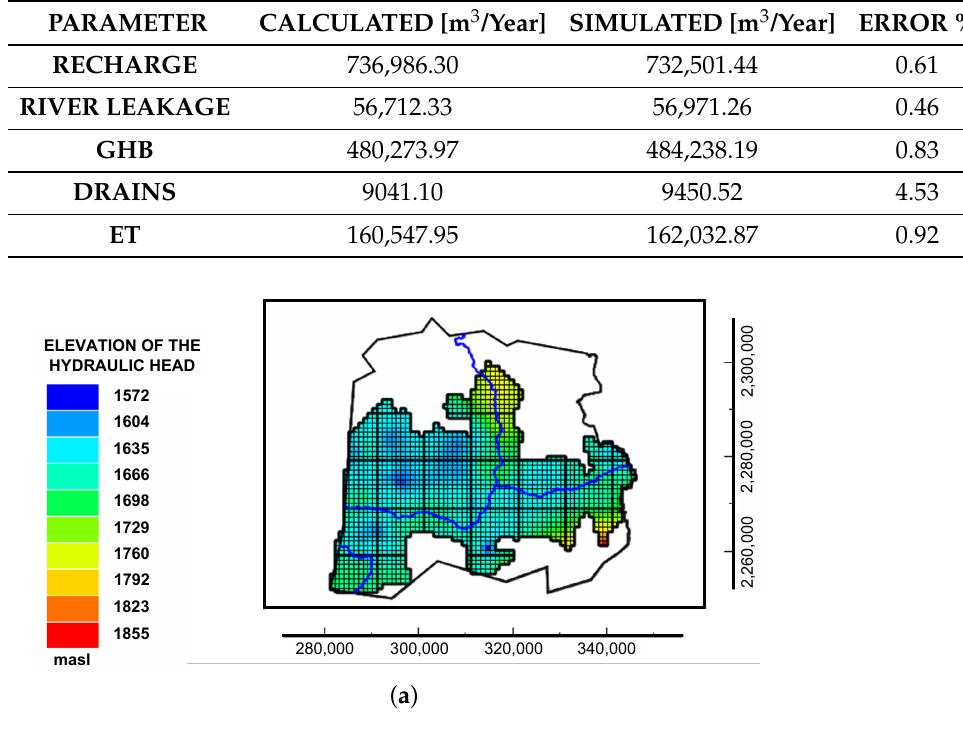
Table 3. Percentage of error for the calibration in steady state of the dry season.